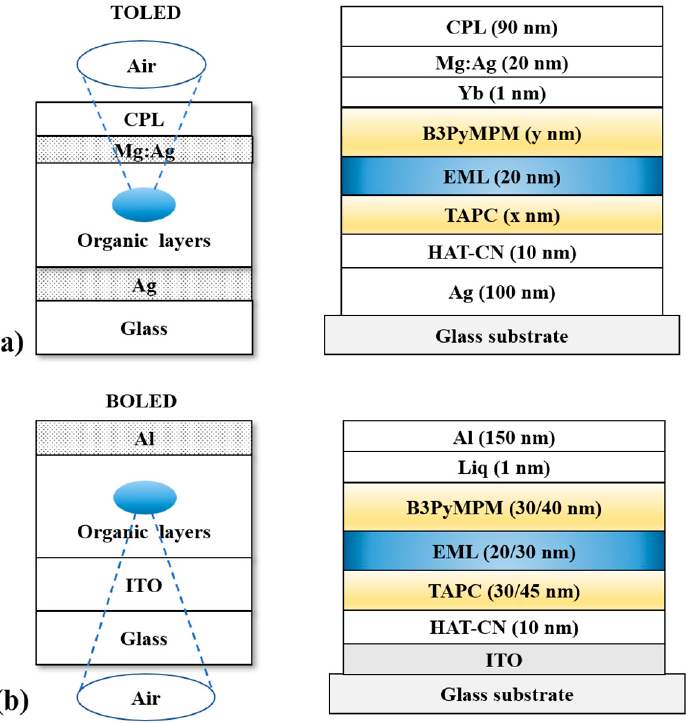
Figure 1. ( a ) Schematic diagram of TOLED; ( b ) schematic diagram of BOLED. The blue layer is the EML and the yellow layers are the charge transporting